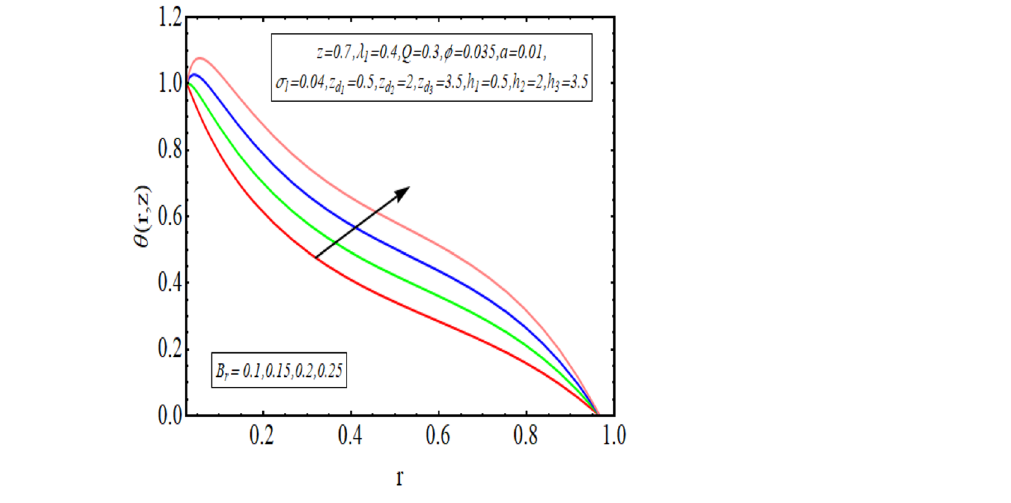
Figure 7. Temperature profile for B r .